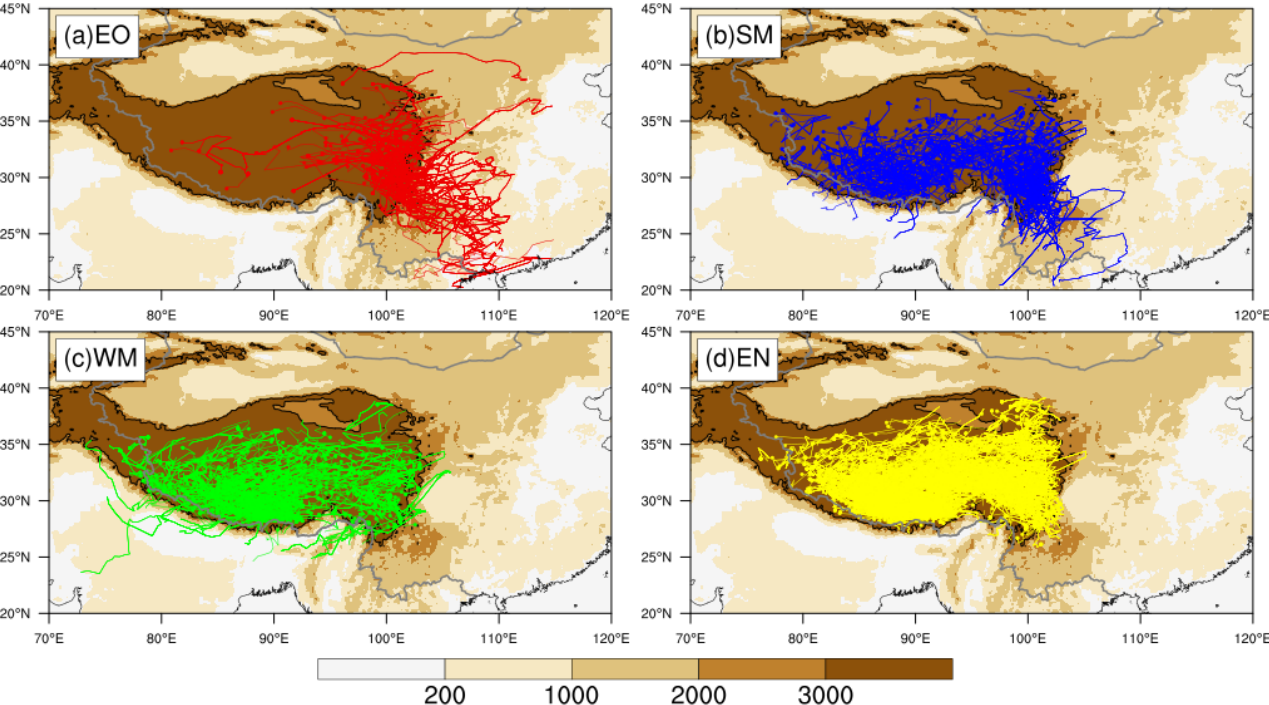
Figure 6. Initiation location (points in color) and tracks (thin curves in color) of MCSs initiated over the TP. ( a ) EOs; ( b ) SMs; ( c ) WMs; ( d ) ENs. The shading area and the black line represent the terrain and the 3000 m terrain height, respec- tively.